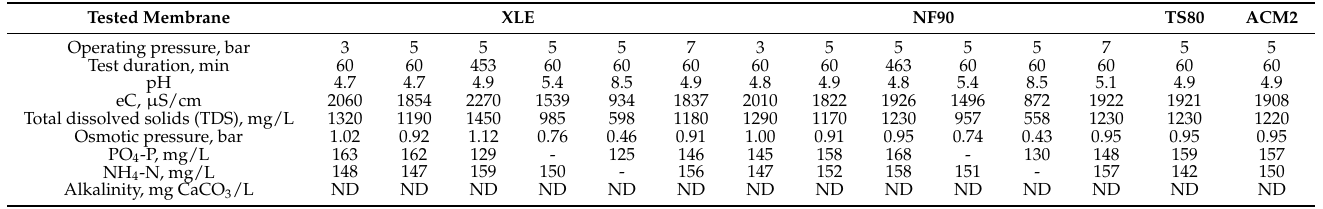
Table A2. Physicochemical characteristics of the synthetic feed solutions used in the preliminary study of membrane performance for liquid digestate treatment.